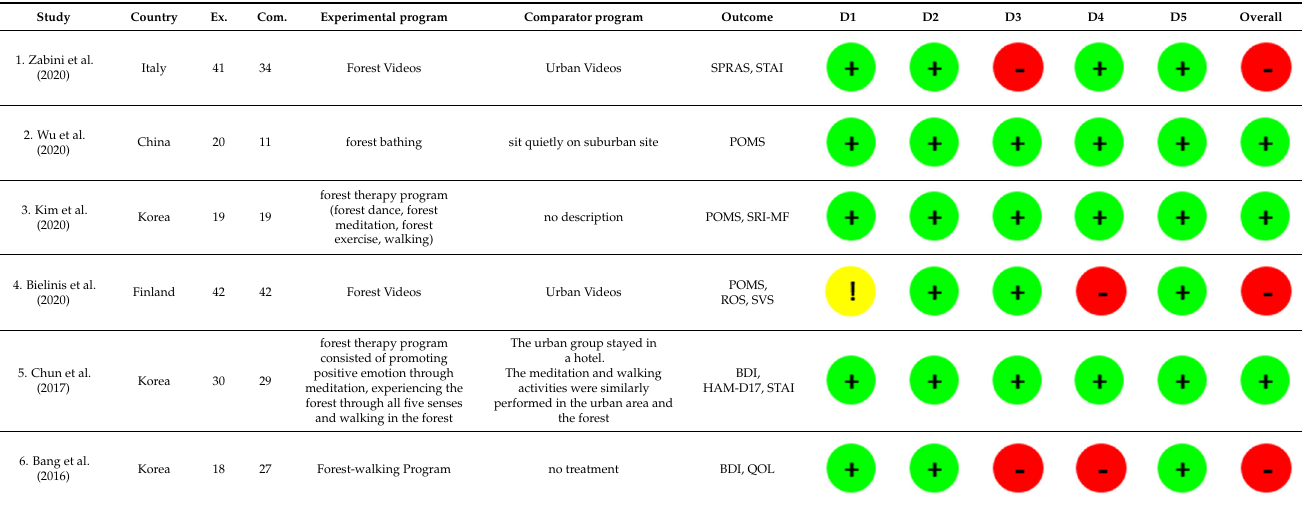
Table 1. General characteristics and risk of bias assessment of included randomized controlled trials ( n = 6).